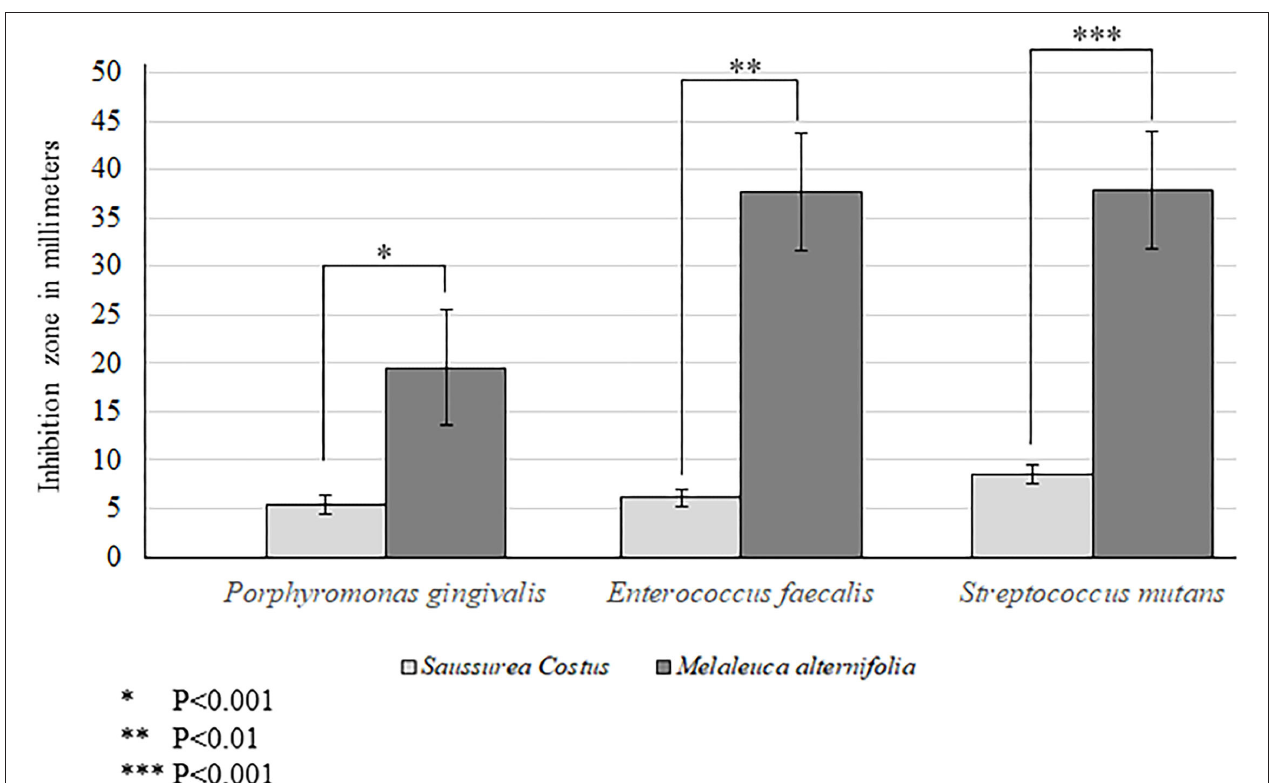
FIGURE 1 | Antibacterial efficacy of Melaleuca alternifolia and Saussurea costus .